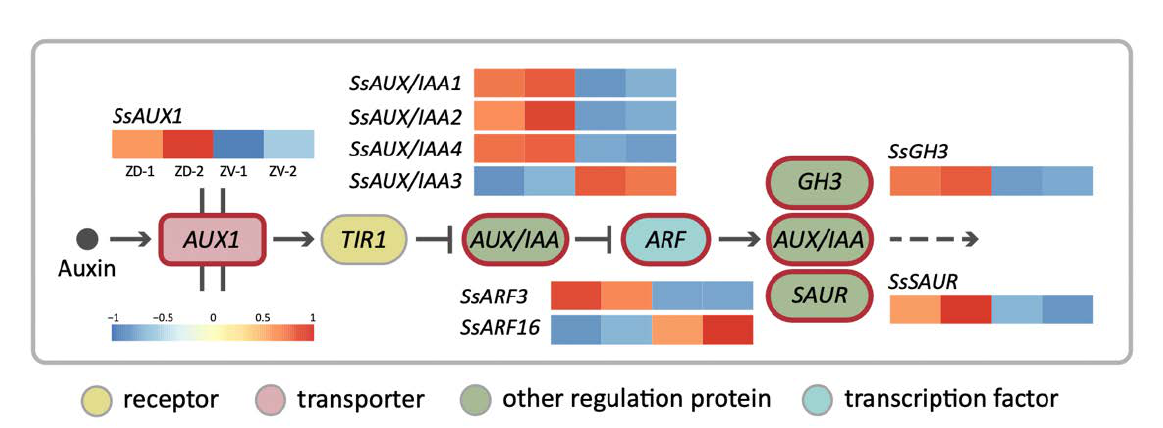
Figure 3. The Gene Ontology (GO) enrichment analysis for the significantly enriched GO terms be- longing to the ‘biological process’ GO category for the 630 DV-DEGs in S. speciosa ‘ES’. Node size is proportional to the number of genes, and the color scale represents the significance levels: white, no significant difference; yellow, p -value < 5 × 10 −2 ; orange, p -value < 5 × 10 −7 . Color shadings refer to the GO terms that relate to six broad biological functions. Arrows indicate connections between GO annotations.